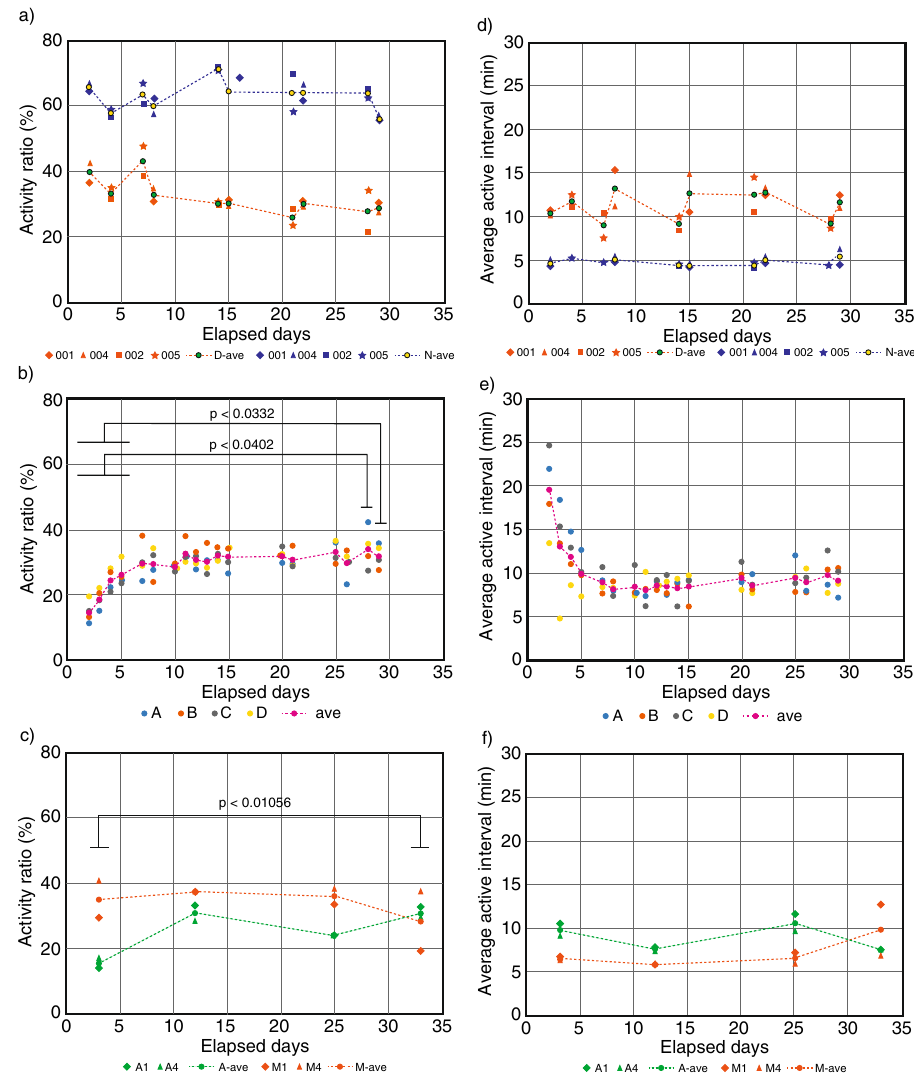
Figure 3. The activity ratio and active interval for elapsed days. The activity ratio and active interval for elapsed days in GC ( a , d ) blue dots at night-time and orange dots at daytime, HG ( b , e ) at daytime, green dots at AG and red dots at MG ( c , f ). The horizontal axis is elapsed days, and the vertical axis is the activity ratio (%). The dashed line represents the average activity ratio. The horizontal bar in the figure shows the range of